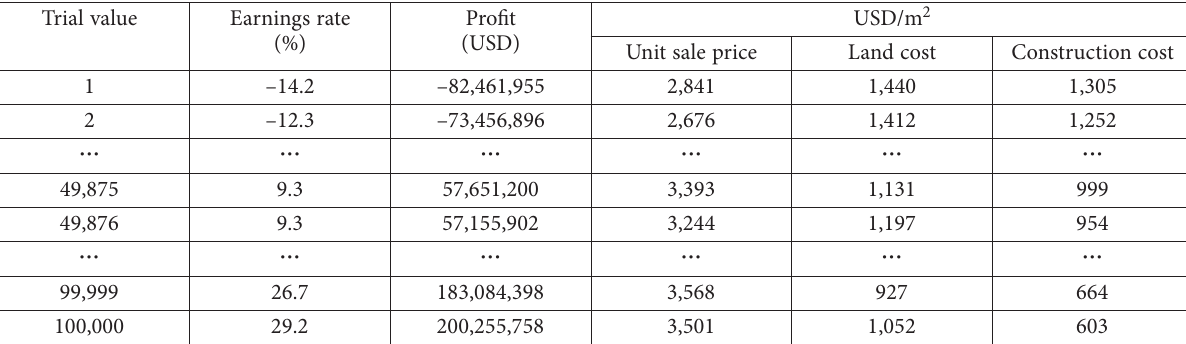
Table 4. Setting the control limits